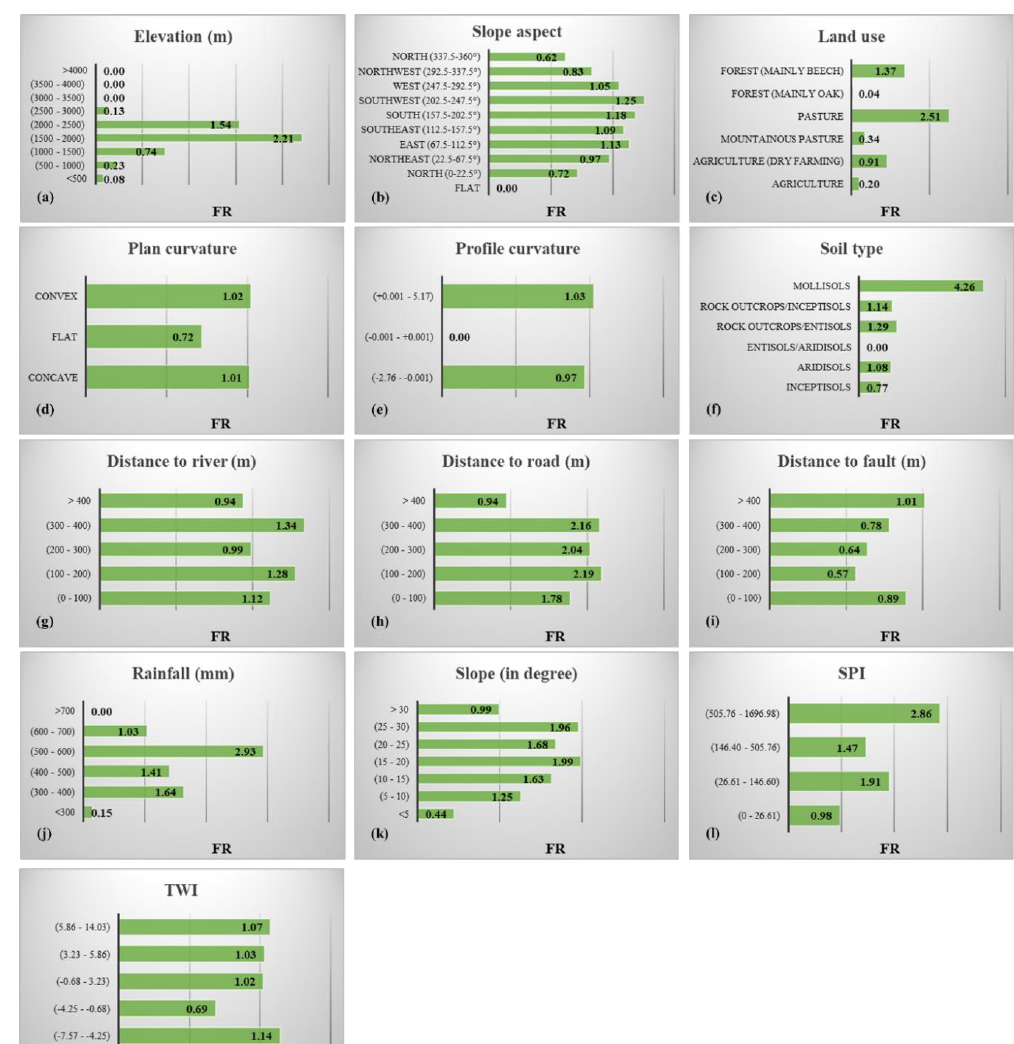
Figure 3. The calculated frequency ratios (FRs) for sub-classes of: ( a ) elevation, ( b ) slope aspect, ( c ) land use, ( d ) plan curvature, ( e ) profile curvature, ( f ) soil type, ( g ) distance to river, ( h ) distance from road, ( i ) distance from fault, ( j ) rainfall, ( k ) slope degree, ( l ) SPI and ( m ) TWI landslide conditioning factors.